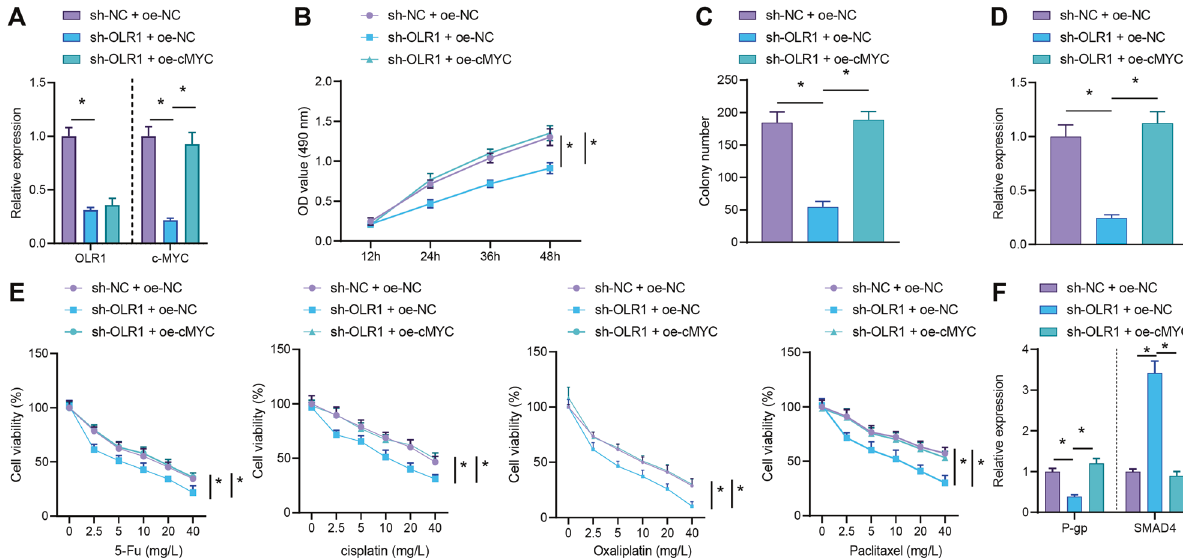
Fig. 3 OLR1 knockdown causes c-MYC downregulation to restrain proliferation and chemoresistance of colon cancer cells. Colon cancer cells were treated with sh-NC + oe-NC, sh- OLR1 + oe-NC, or sh- OLR1 + oe-c-MYC. A The mRNA expression of OLR1 and c-MYC in colon cancer cells determined by RT-qPCR. B MTS to measure the proliferation of colon cancer cells. C Colony formation of colon cancer cells detected by colony formation assay. D The mRNA expression of Ki67 in colon cancer cells checked by RT-qPCR. Colon cancer cells were treated with sh-NC + oe-NC, sh- OLR1 + oe-NC, or sh- OLR1 + oe-c-MYC, followed by treatment with DDP, oxaliplatin, 5-Fu, and paclitaxel. E The drug resistance of colon cancer cells to DDP, oxaliplatin, 5-Fu, and paclitaxel assessed by MTS. F RT-qPCR to detect the mRNA expression of P-gp and SMAD4 in colon cancer cells. The cell experiments were repeated three times. * p < 0.05 between two